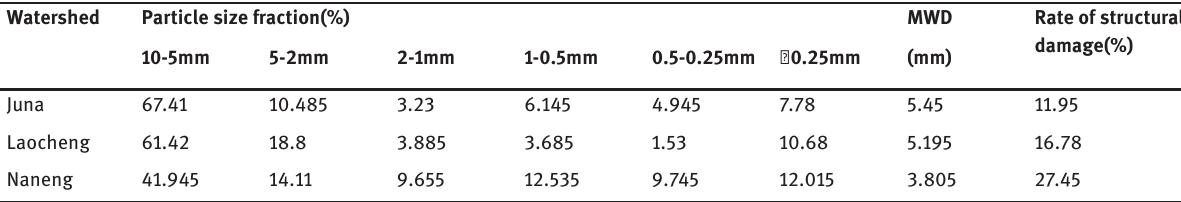
Table 4: Characteristics of soil wet - dry agglomerate and its structural damage rate. Watershed